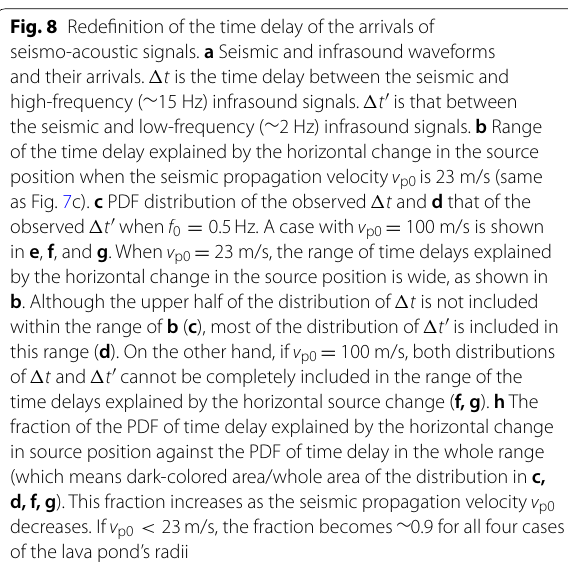
Fig. 8 Redefinition of the time delay of the arrivals of seismo-acoustic signals. a Seismic and infrasound waveforms and their arrivals. (cid:31) t is the time delay between the seismic and high-frequency ( ∼ 15 Hz) infrasound signals. (cid:31) t ′ is that between the seismic and low-frequency ( ∼ 2 Hz) infrasound signals. b Range of the time delay explained by the horizontal change in the source position when the seismic propagation velocity v p0 is 23 m/s (same as Fig. 7c). c PDF distribution of the observed (cid:31) t and d that of the observed (cid:31) t ′ when f 0 = 0.5 Hz. A case with v p0 100 m/s is shown = in e , f , and g . When v p0 23 m/s, the range of time delays explained = by the horizontal change in the source position is wide, as shown in b . Although the upper half of the distribution of (cid:31) t is not included within the range of b ( c ), most of the distribution of (cid:31) t ′ is included in this range ( d ). On the other hand, if v p0 100 m/s, both distributions = of (cid:31) t and (cid:31) t ′ cannot be completely included in the range of the time delays explained by the horizontal source change ( f, g ). h The fraction of the PDF of time delay explained by the horizontal change in source position against the PDF of time delay in the whole range (which means dark-colored area/whole area of the distribution in c, d, f, g ). This fraction increases as the seismic propagation velocity v p0 decreases. If v p0 < 23 m/s, the fraction becomes ∼ 0.9 for all four cases of the lava pond’s radii